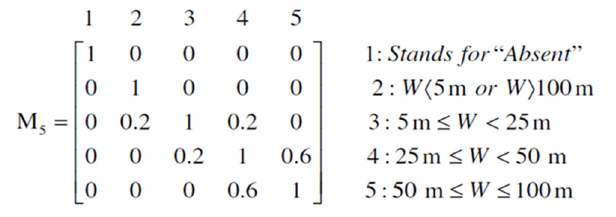
Figure 3. Grading matrices for “Beach face width” parameter (point 5, Table 1, CSES).